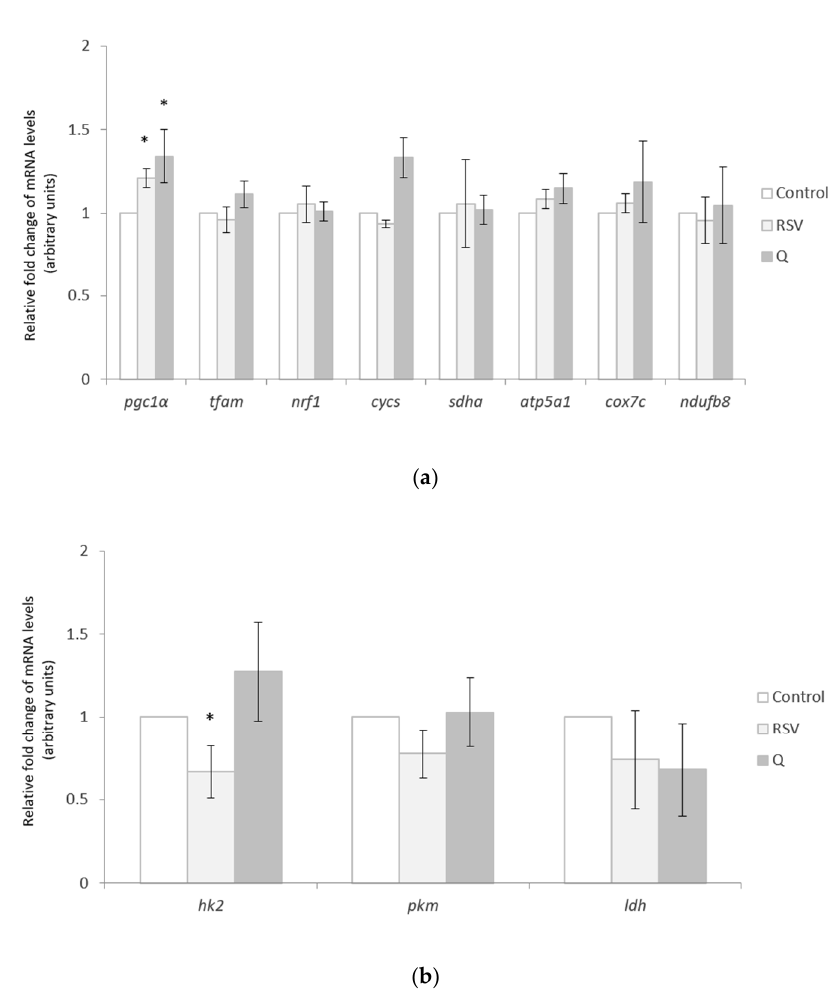
Figure 1. Mitochondrial ( a ) and cytosolic ( b ) gene expression in human myotubes treated with 0.1 μM of resveratrol (RSV) and 10 μM of quercetin (Q) for 24 h. All of the data are presented as the mean ± SEM of two independent experiments ( n = 6 per group). Comparisons between biological replicates of each treatment group and biological replicates of the control group were analysed by Student’s (cid:1872) -test. The asterisks represent differences versus the controls ( * p < 0.05).